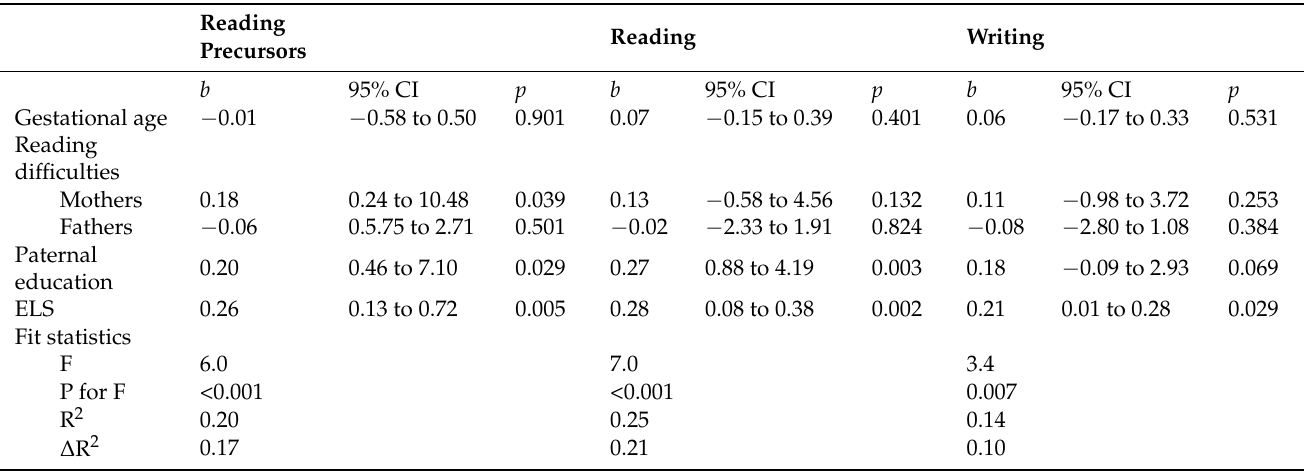
Table 7. Results of multiple variable linear regression analysis with reading precursors, reading, and writing skills at 7 years of age as dependent variables, and with ELS at 2 years of corrected age and background factors as independent variables. Results of VP/VLBW children are presented.